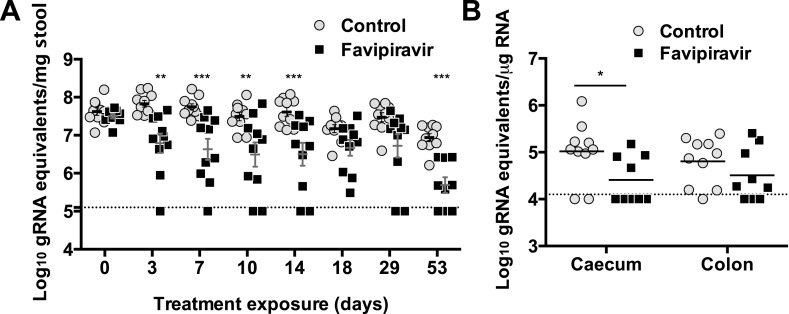
Long exposure to favipiravir results in significantly decreased norovirus RNA levels in animal tissues and faeces.Two groups of ten male C57BL/6 mice of 4–5-weeks were oral gavage-infected with 104 TCID50 units of MNV-3. 4 weeks after virus inoculation, persistently infected animals were subjected to treatment with either 300 mg/kg animal of favipiravir twice a day (FPV) or with buffer (Control) for 8 weeks. At day 53, there are nine animals instead of ten in favipiravir-treated group due to the accidental death of one mouse during dosing. A dashed line indicates the limit of detection (102 genome copy equivalent per mg of stool). (A) Viral genome copy equivalents isolated in faecal samples (p < 0.05, *; p < 0.01, **; p < 0.001, ***; 2-way ANOVA test). Viral RNA extracted was then reverse transcribed and quantitated as described in ‘Materials and methods’. (B) Viral genome copy equivalents isolated in caecum and colon (p < 0.05, *; 2-way ANOVA test).